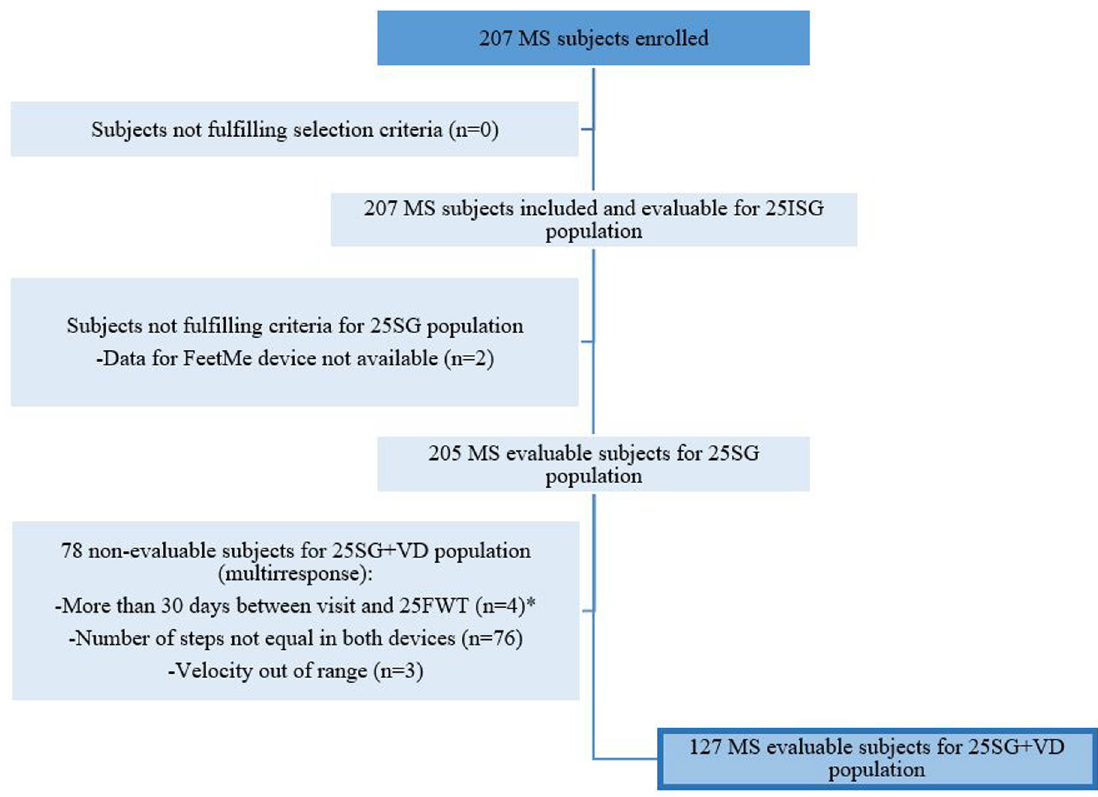
Fig 2. Flowchart of subject disposition. 25SG = T25WT-both devices subject group; 25SG+VD = T25WT-both devices subject group with valid data; 25ISG = T25WT intended subject group; MS = Multiple sclerosis; T25WT = times 25-feet walk. � 10 subjects did not perform 25FWT the same day due to following reasons: Malfunction or alteration of the features / benefits of FeetMe 1 , Malfunction or alteration of the characteristics / benefits of GAITRite, Reasons intrinsic to the subject (inability to walk, does not finish the 8 m of the test, etc.), Problems unrelated to the device and the subject (operation of the service, etc.), Withdrawal of informed consent by the subject, other reasons.